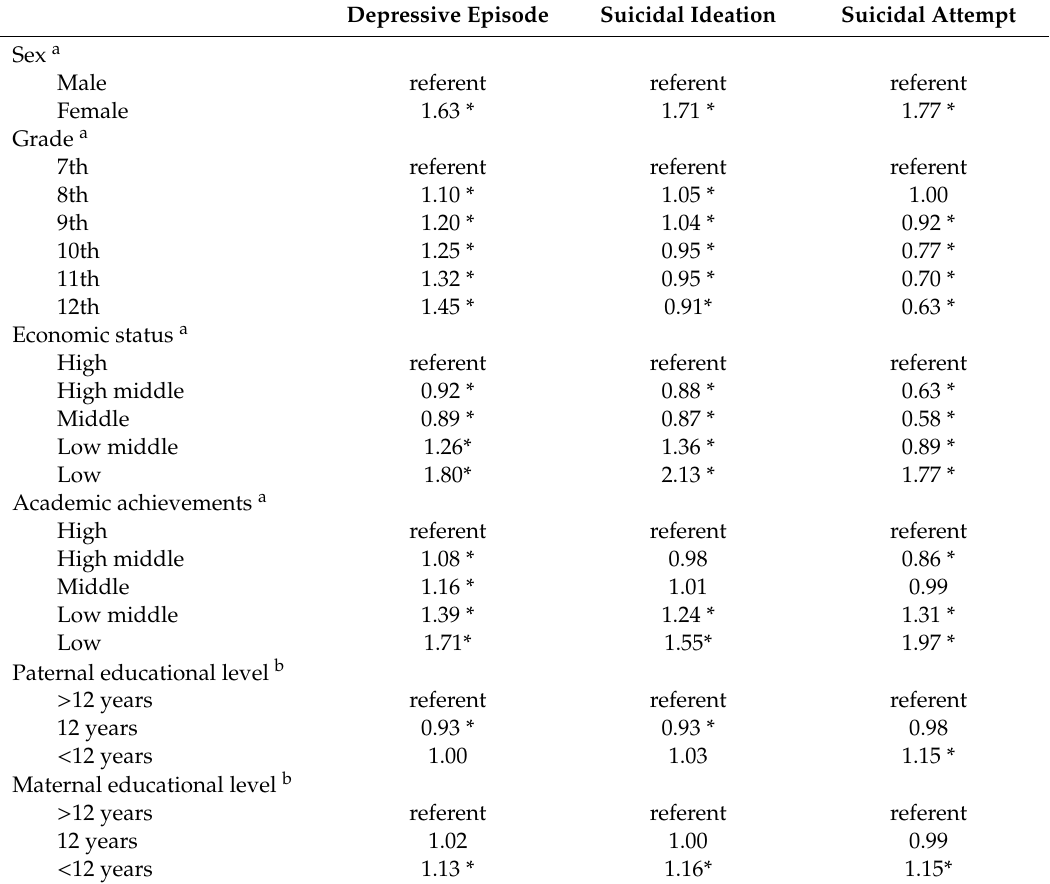
Table 3. Odds ratio for the depressive episode, suicidal ideation, and suicidal attempt. Depressive